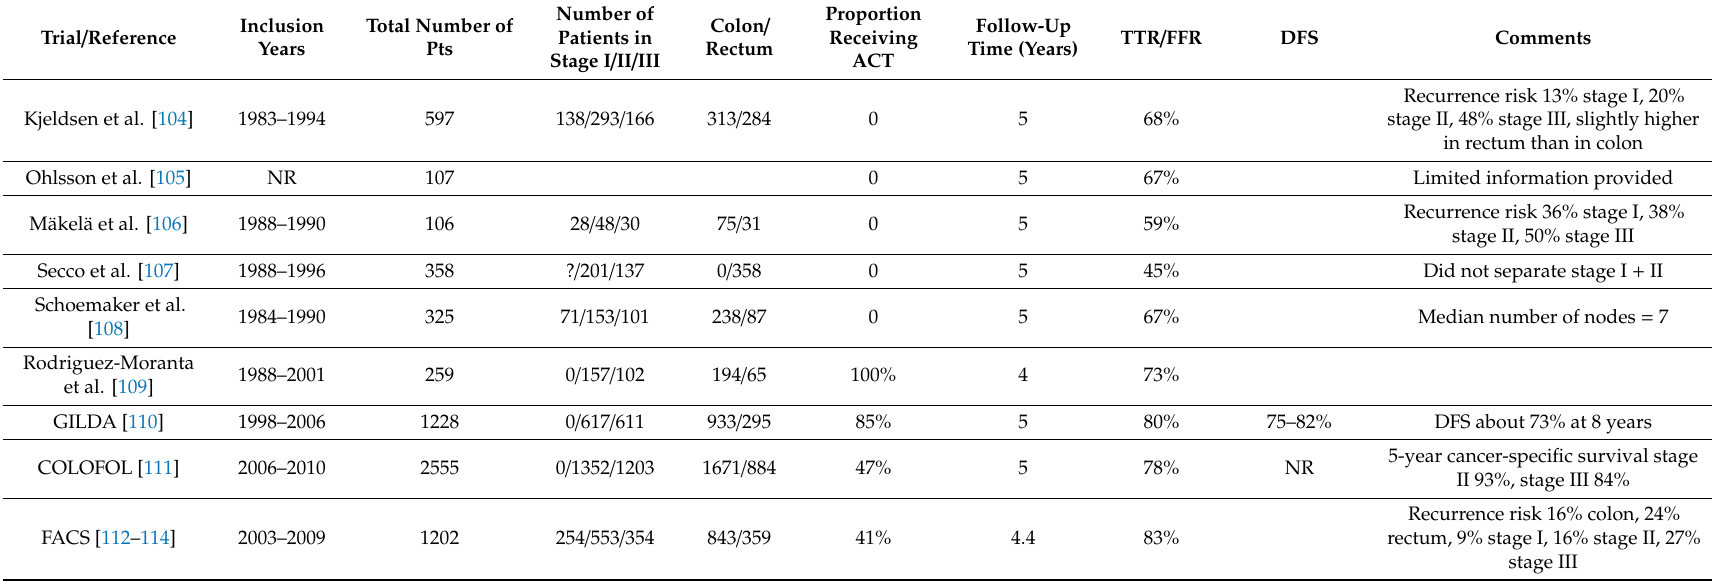
Table 4. Time to recurrence rate / freedom from recurrence and disease-free survival in studies comparing di ff erent follow-up routines in colorectal